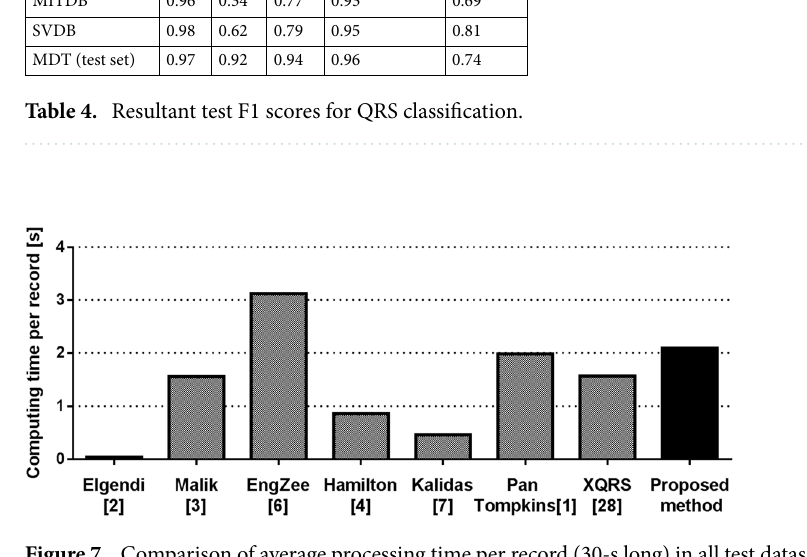
Figure 7. Comparison of average processing time per record (30-s long) in all test datasets (excluding the CYBHi